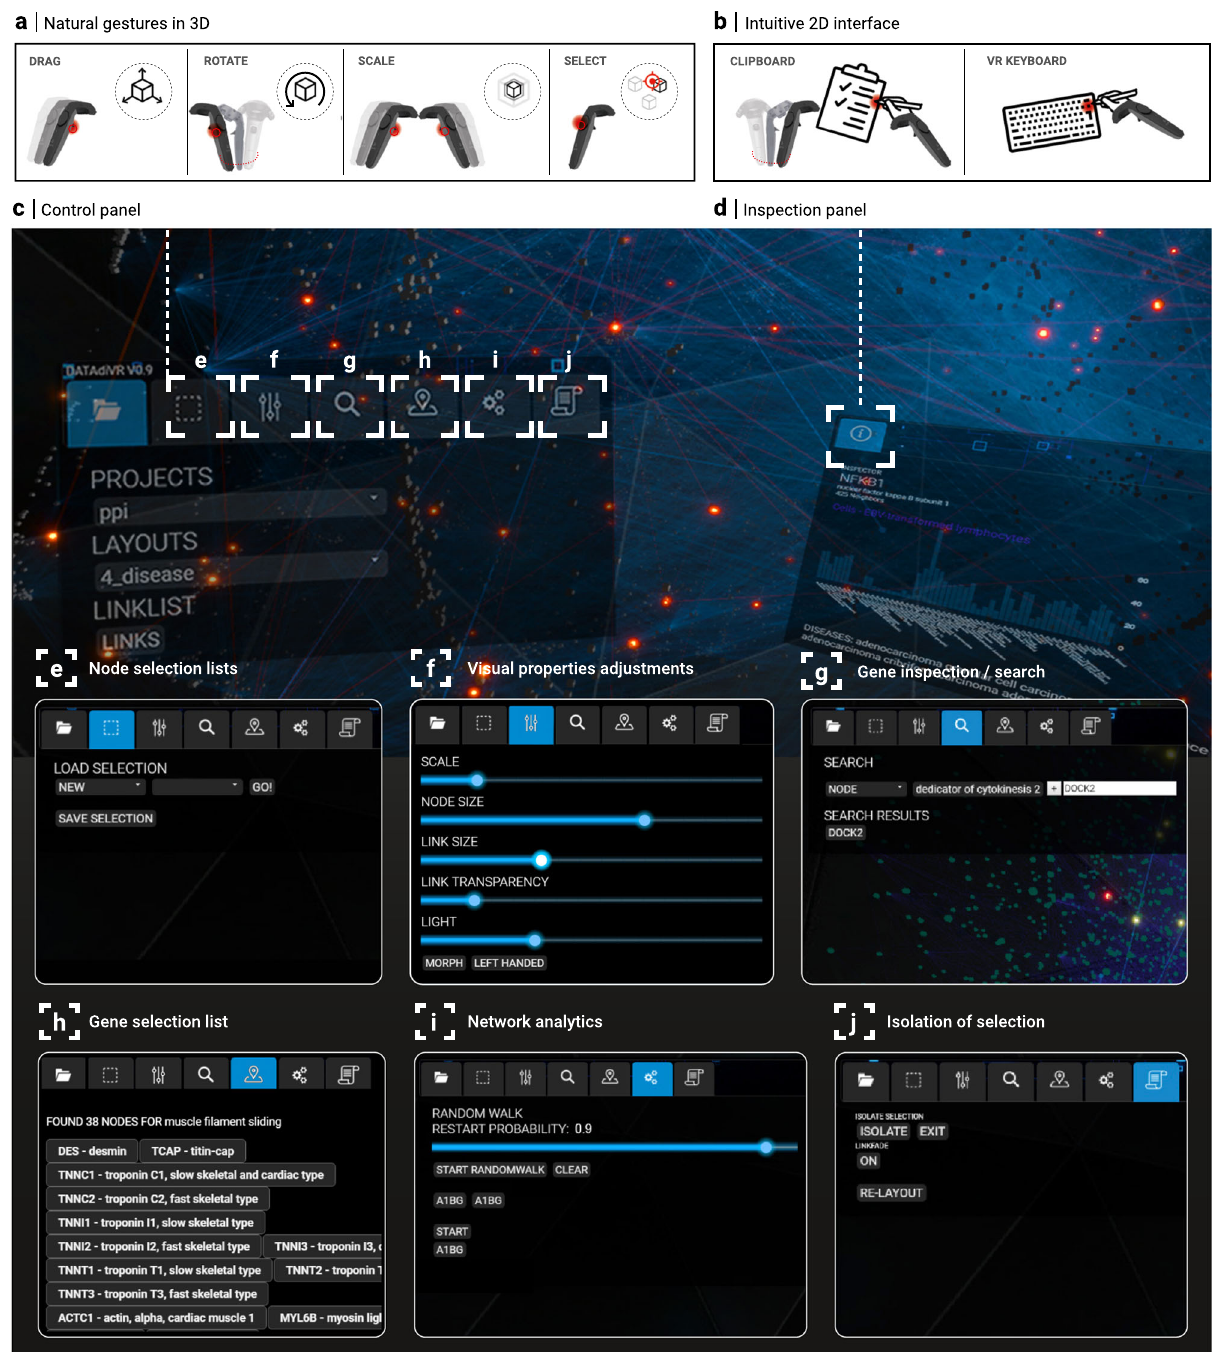
Fig. 3 User interaction design. a Interactions with the 3D network, such as moving the network or selecting individual nodes, are implemented as natural 3D gestures. The movement of the controllers with pressed trigger buttons (indicated in red) is directly translated into the corresponding movement of the network, allowing the user to drag, rotate, and scale the network. Individual nodes are selected by directly pointing at them. b , All other interactions are performed through 2D interfaces dedicated to speci fi c tasks. The core functionalities are collected into a control panel that spawns as a virtual clipboard in one hand, and a virtual stylus in the other, which can also be used to type on a virtual keyboard. VR screenshots showing the ( c ) control panel and a particular ( d ) inspection panel. Inspection panels are used to display the results of a particular action or analysis, such as providing detailed annotations for a selected node. e – j Screenshots of the different core functionalities, organized as different tabs in the control panel. e Loading (saving) speci fi c node sets from (to) the database. f Adjusting visual properties of the network. g Searching for nodes and node sets, either by name or any other attribute contained in the database. Searches can also be combined using logical operators. h List of currently selected nodes. i User interface for running network analytics, such as random walk with restart from a selected node set. j Highlighting node selections.